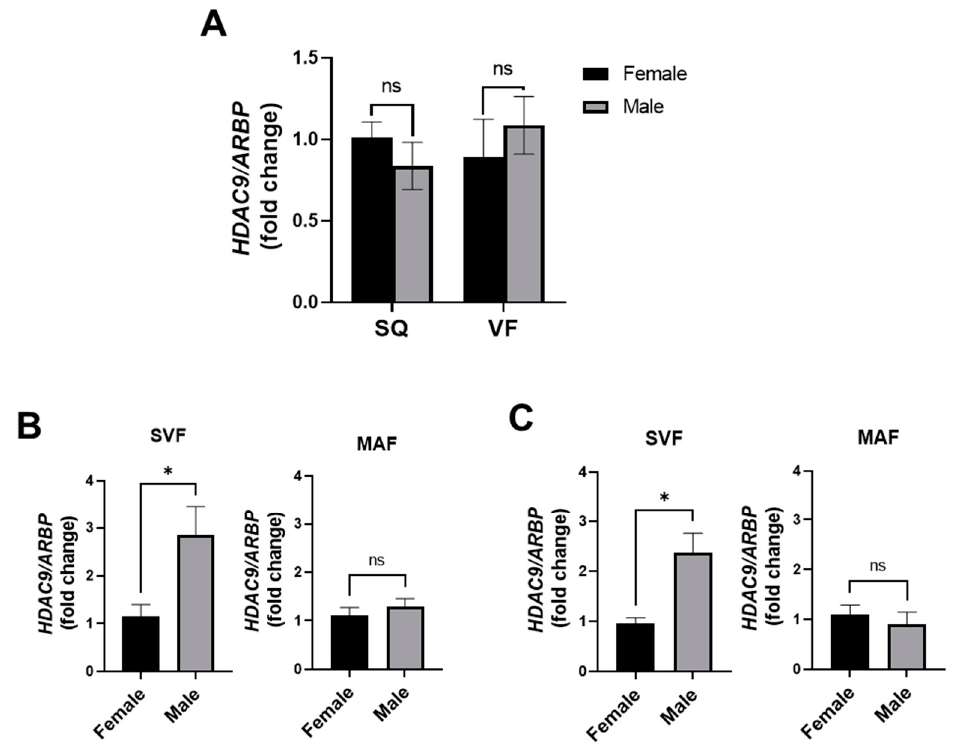
Figure 7. HDAC9 is differentially expressed in SVF of male compared to female mice. ( A ) HDAC9 mRNA expression in SQ and VF from HFD-fed female and male WT mice ( n = 4–7). HDAC9 mRNA expression in SVF and MAF from SQ ( B ) and VF ( C ) of HFD-fed WT mice ( n = 6–7). Data represent mean ± SEM. * p < 0.05, ns, not significant. SQ, subcutaneous adipose tissue; VF, visceral adipose tissue; SVF, stromovascular fraction; MAF, mature adipocyte fraction.